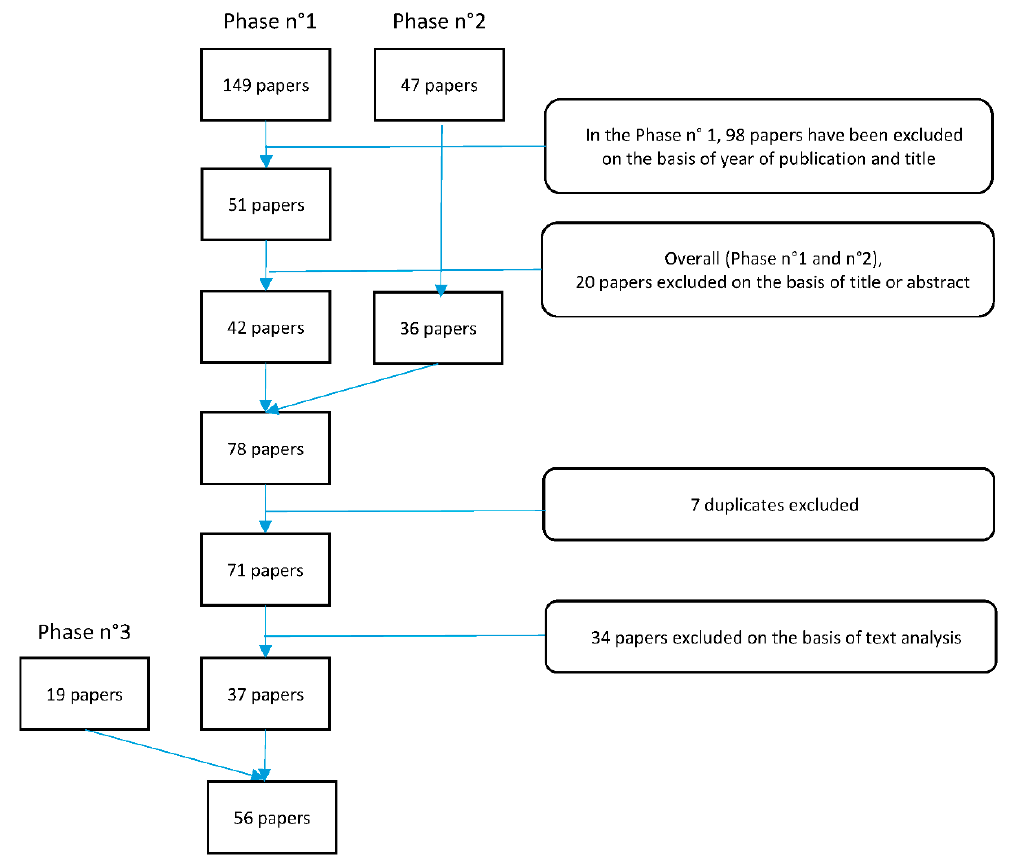
Figure 2. Flow chart of the search method.